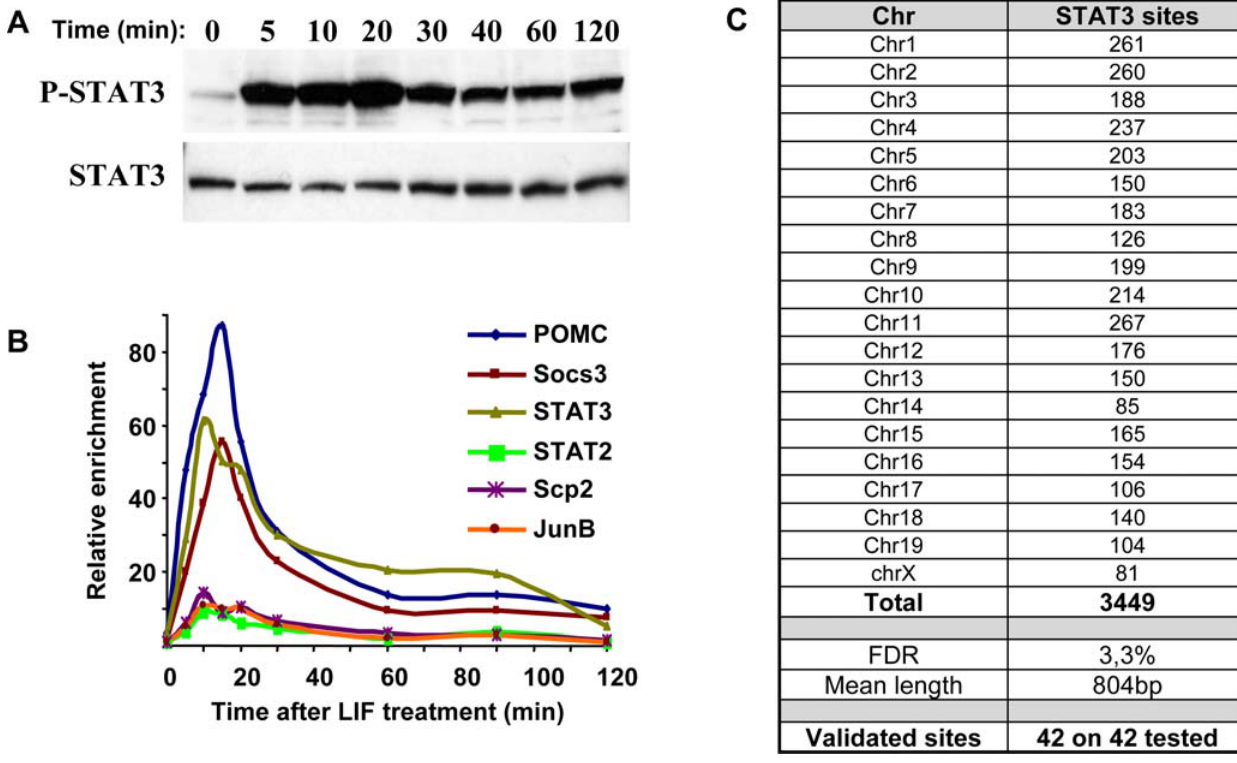
Figure 1. Targets of LIF/STAT3 action. A) The time course of STAT3 activation (phospho- STAT3) was determined in AtT-20 cells following treatment with LIF (10 ng/ml). Western blot analysis of P-STAT3 is compared to total STAT3 protein. B) Time course of STAT3 occupancy on the promoter of known STAT3 target genes determined by ChIP and QPCR. C) Chromosomal distribution of genomic binding sites for STAT3 determined by ChIP-chip analysis of LIF-treated (20 min) AtT-20 cells. Triplicate ChIP samples were analyzed on Affymetrix Mouse Tiling 2.0R Array Sets. Raw data were extracted with GCOS software (Affymetrix) and were analyzed using the MAT software package. STAT3 enrichment peaks were selected on the basis of a P value threshold of 10 2 5 . Redundant sequence filtering led to the removal of 74 sequences, thus yielding a final count of 3449 STAT3 binding sites. The list of these sites is presented in Table S1. The tiling array results were validated by QPCR analysis of independent ChIPs for 42 loci distributed randomly throughout all chromosomes; all 42 were confirmed. The same loci were used for further studies in Figure 3. FDR, calculated false discovery rate.